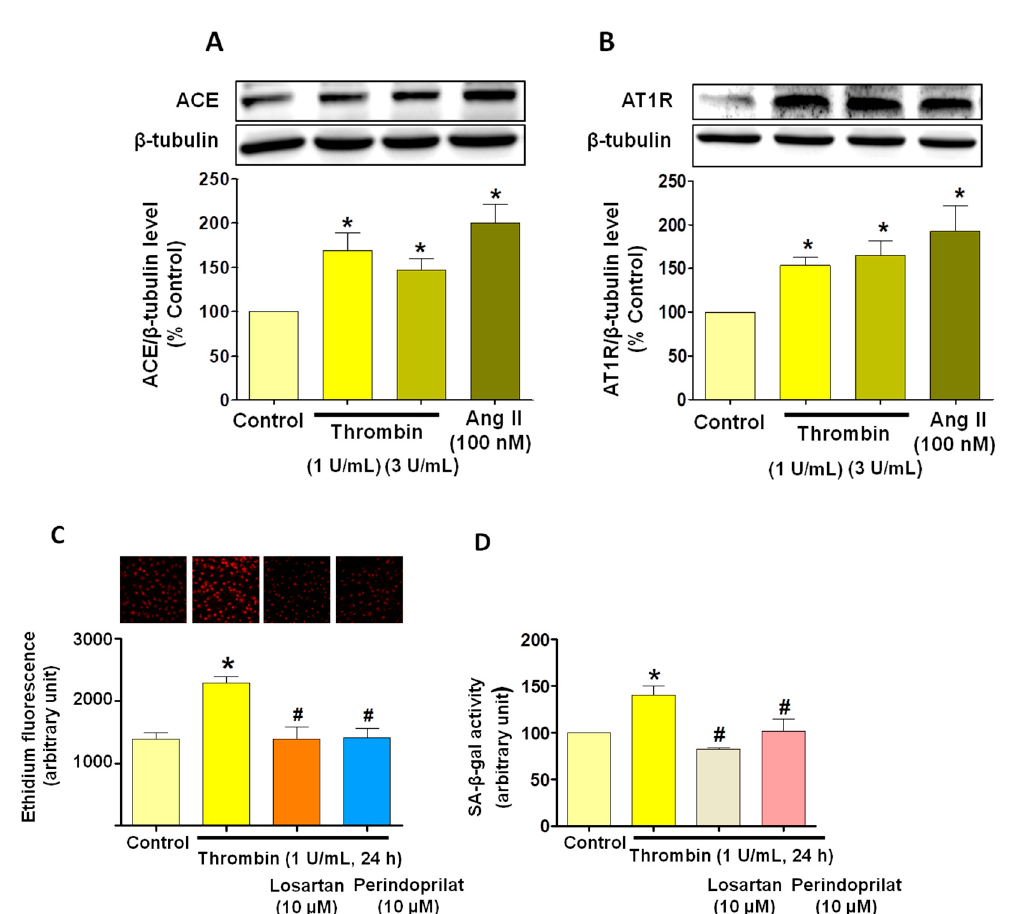
Figure 6. Thrombin-induced senescence promotes up-regulation of the local angiotensin system in atrial ECs. Atrial ECs were either untreated or exposed to losartan (AT1R antagonist) or perindoprilat (ACE inhibitor) before the addition of thrombin (1 U/mL) or AngII (100 nM) for 24 h, and the subsequent determination of the expression level of target proteins ( A, B ) as assessed by Western blot analysis, ( C ) oxidative stress by confocal microscopy, and ( D ) SA- β -gal activity using flow cytometry. Results are shown as representative immunoblots (upper panels) and corresponding cumulative data (lower panels) and shown as mean ± SEM, n = 3–4, * P < 0.05 versus respective control, # P < 0.05 versus thrombin-treated atrial ECs.